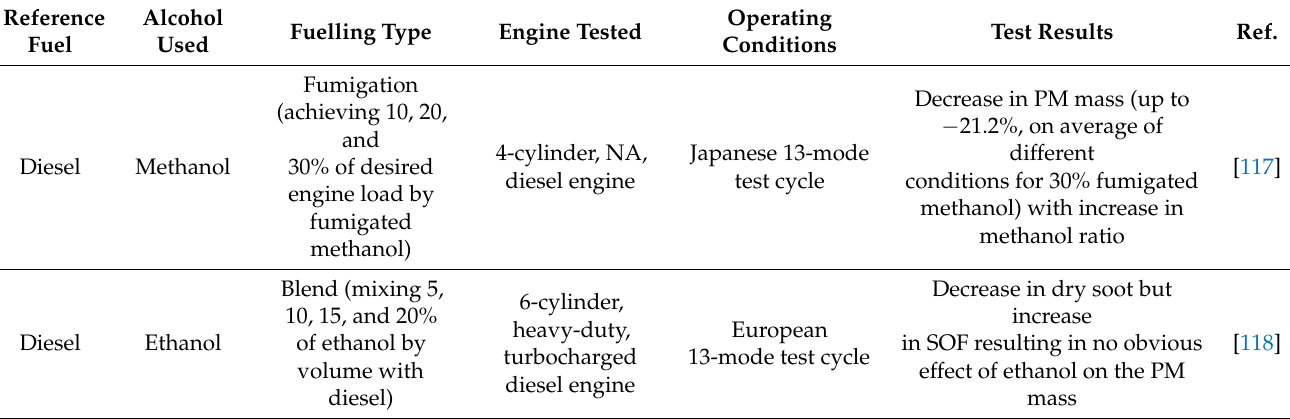
Table 3. Reviewed investigations available in the literature about the PM physicochemical properties of internal combustion